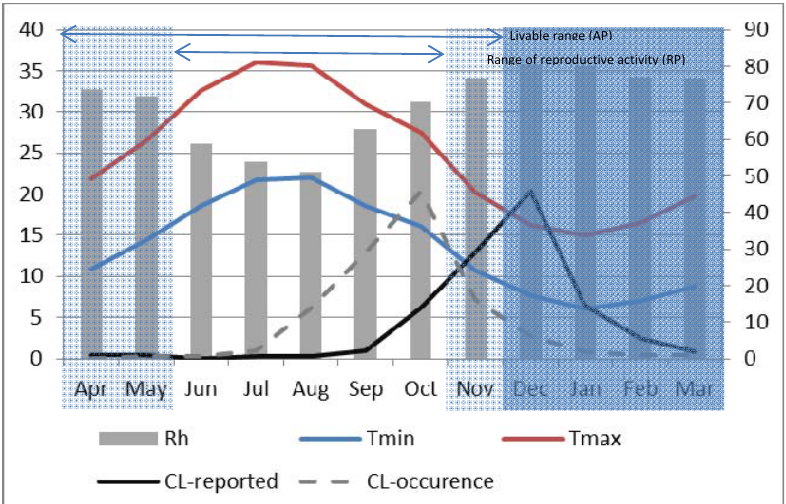
Figure 6. Monthly composite relative humidity (bar, right axis). Maximum (red) and minimum (blue) temperatures (left axis) for P2 at Saida. Dark shading represents the vector’s period of hibernation. Active and Reproductive periods are indicated by horizontal bars at the top of the graph. The dark solid line represents the monthly average reported ZCL-cases during P2 and the dashed line shows the presumed ZCL-occurrence with a 2-month lag (right